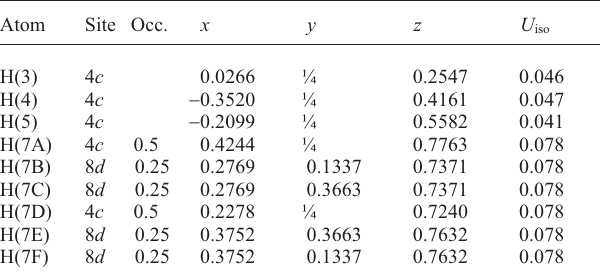
Table 2. Atomic coordinates and displacement parameters (in Å 2 ) . Atom Site